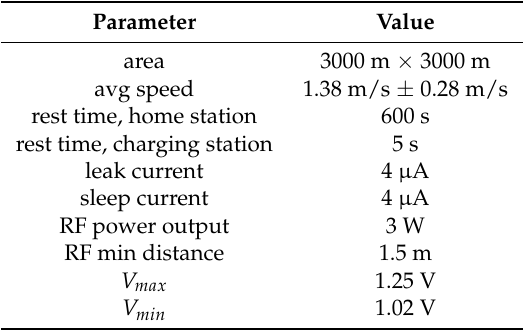
Table 1. Simulation